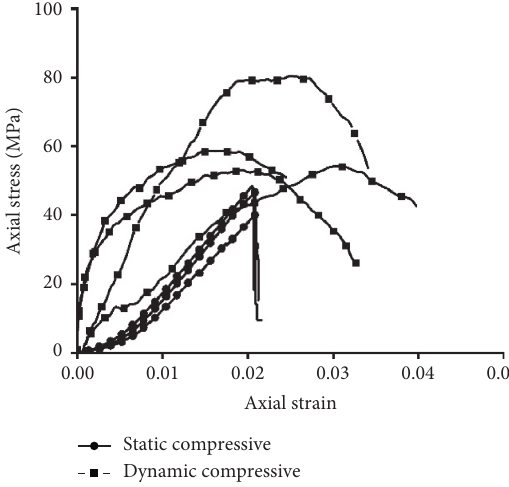
Figure 11: Comparison of dynamic and static compressive stress- strain